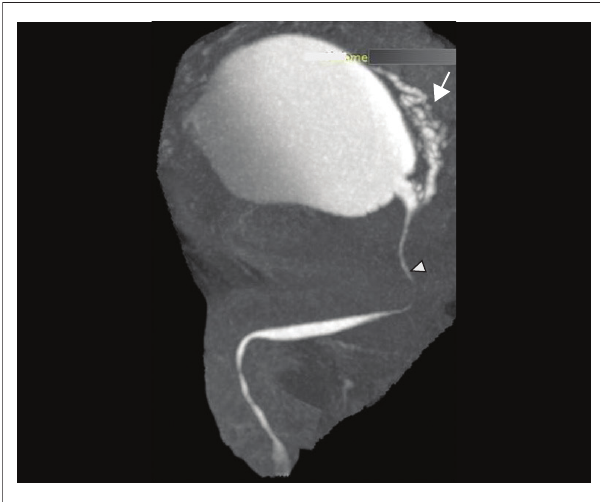
FIG URE 5: Sagittal maximum intensity projection (multidetector computed tomographic urethrography) showing reflux into the prostatic glands and seminal vesicles (arrow) and a urethral stricture of the entire posterior urethra. (arrowhead).